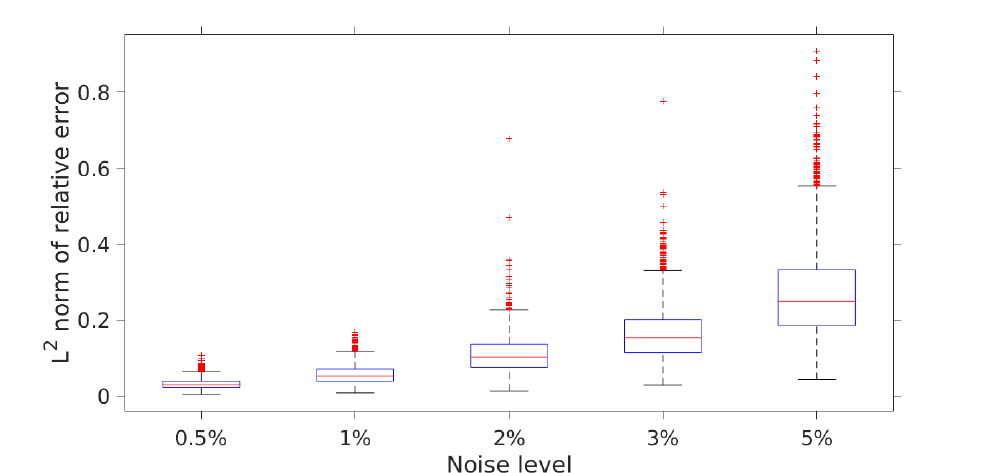
Figure 4. Distribution of the relative errors of the 2000 evaluation data sets with different Gaussian noise levels under the trained model for X 5 with k = 7. The central mark on each box indicates the median and the bottom and top edges of the box indicate the 25th and 75th percentiles, respectively. The whiskers extend to the most extreme data points not considered outliers, and the outliers are plotted individually using the ‘+’ symbol.